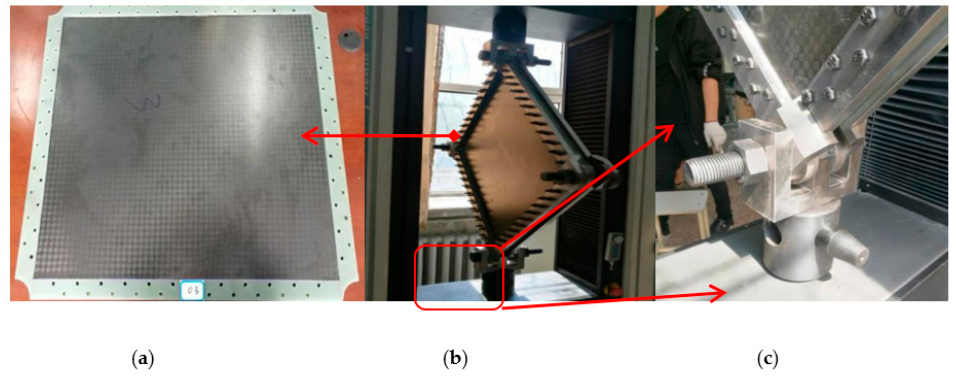
Figure 3. Shear test set-up: ( a ) specimen; ( b ) assembly component; ( c ) corner enlargement.